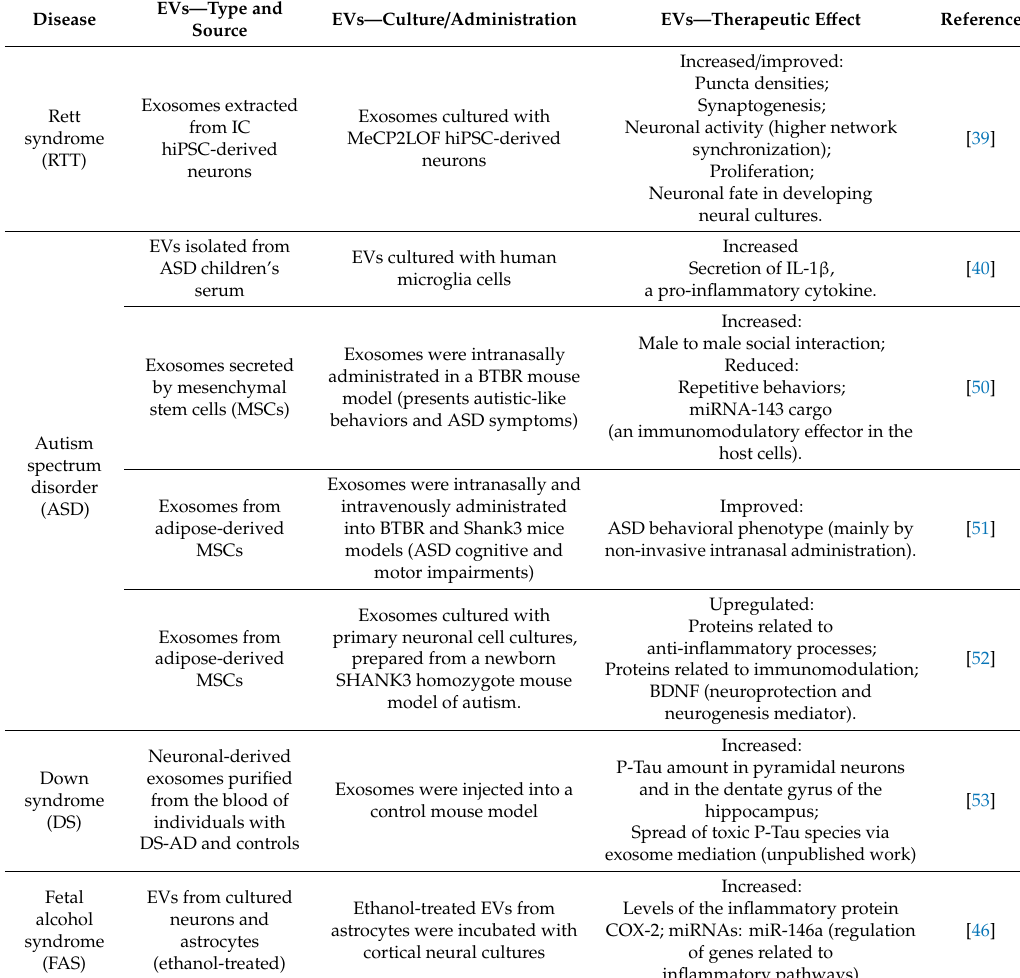
Table 2. EVs cultured or administrated, and their therapeutic e ff ect.